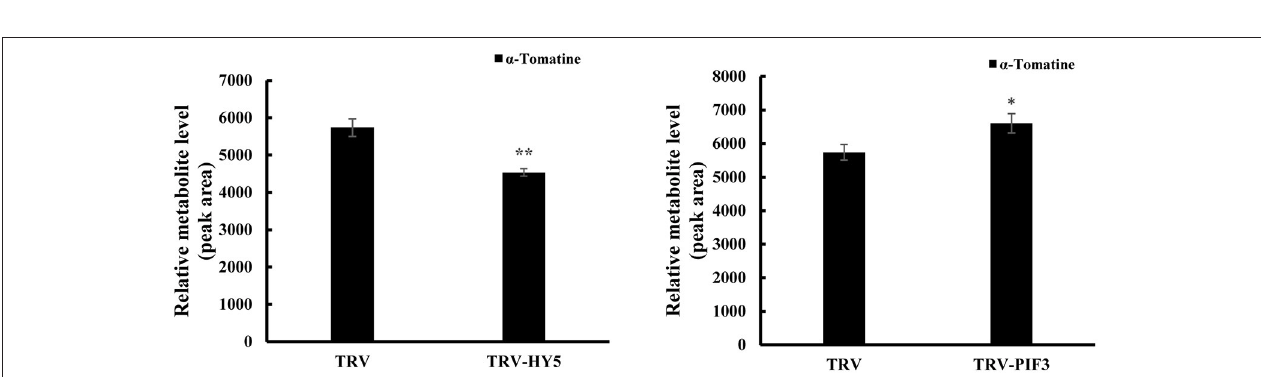
FIGURE 4 | Changes in HY5 and PIF3 expression in tomato leaves results in altered levels of the predominant SGAs. Levels of a-tomatine in leaves determined by UPLC-MS/MS. Tomatine was identified by comparison of its retention time and mass spectrum to those generated for authentic standards analyzed on the same instrument. Relative metabolite levels are expressed as ratios of peak areas. Values represent means ± standard deviation ( n = 3). Student’s t -test was used to assess whether the results with the virus-induced gene silencing plants differed significantly from those for TRV-infected plants (* P < 0.05; ** P < 0.01).